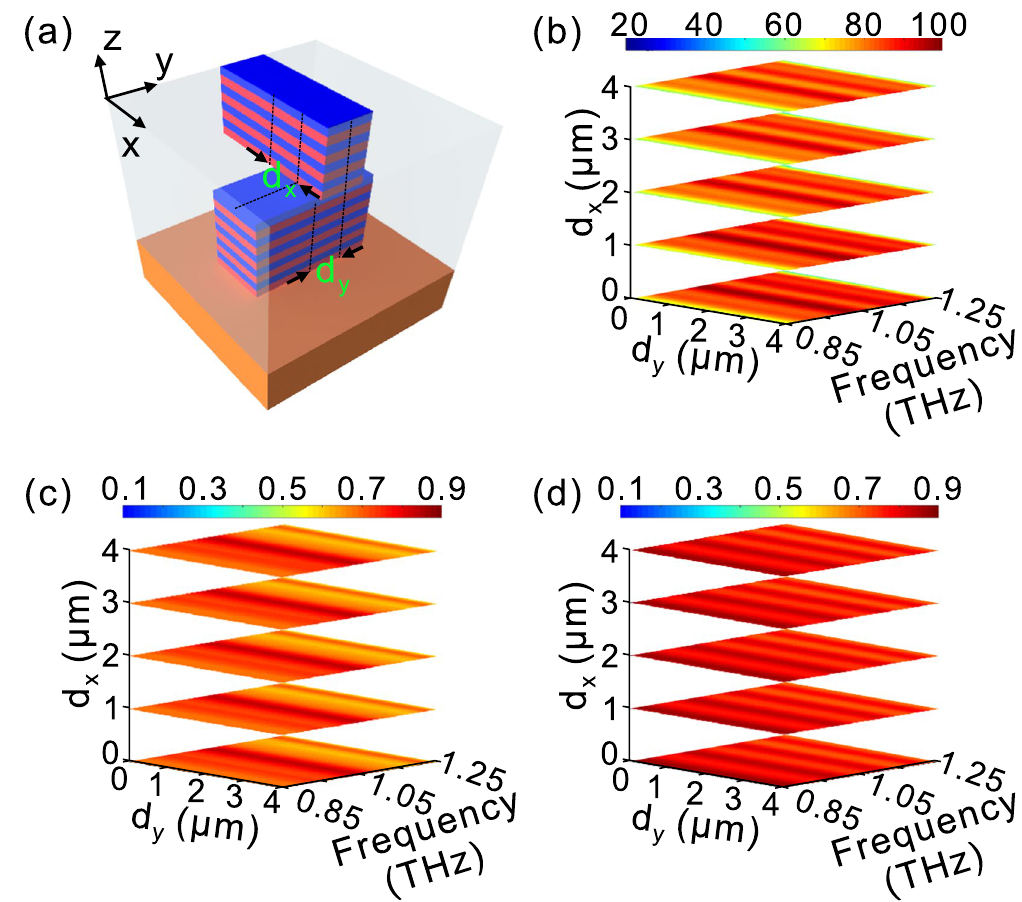
Figure 6. Influence of the dislocation on the performance of the third set of HMM quarter-wave plate in Fig. 4. ( a ) The sketch map of a unit cell of the double-stacked HMM waveguide arrays, in which d x and d y represent the dislocations between the upper and lower HMM waveguide arrays along + x and + y directions, respectively. The influence of misalignment on phase delay ( b ), amplitudes of transmission coefficients for different polarizations, t xx ( c ) and t yy ( d